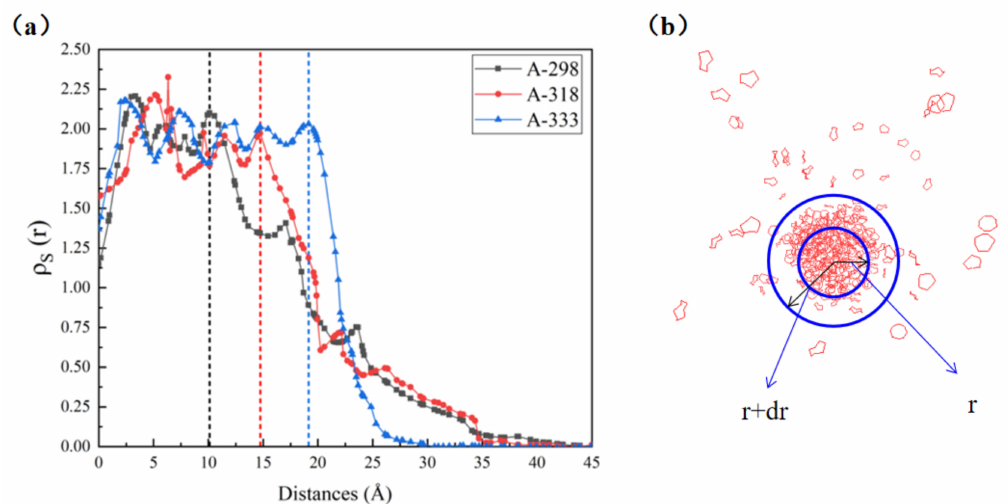
Figure 4. ( a ) The variation trend of ρ S (r) of models A-298, A-318 and A-333 with radius r; ( b ) position projection of S 8 cluster on X-Y plane during simulation (CS 2 molecule is not